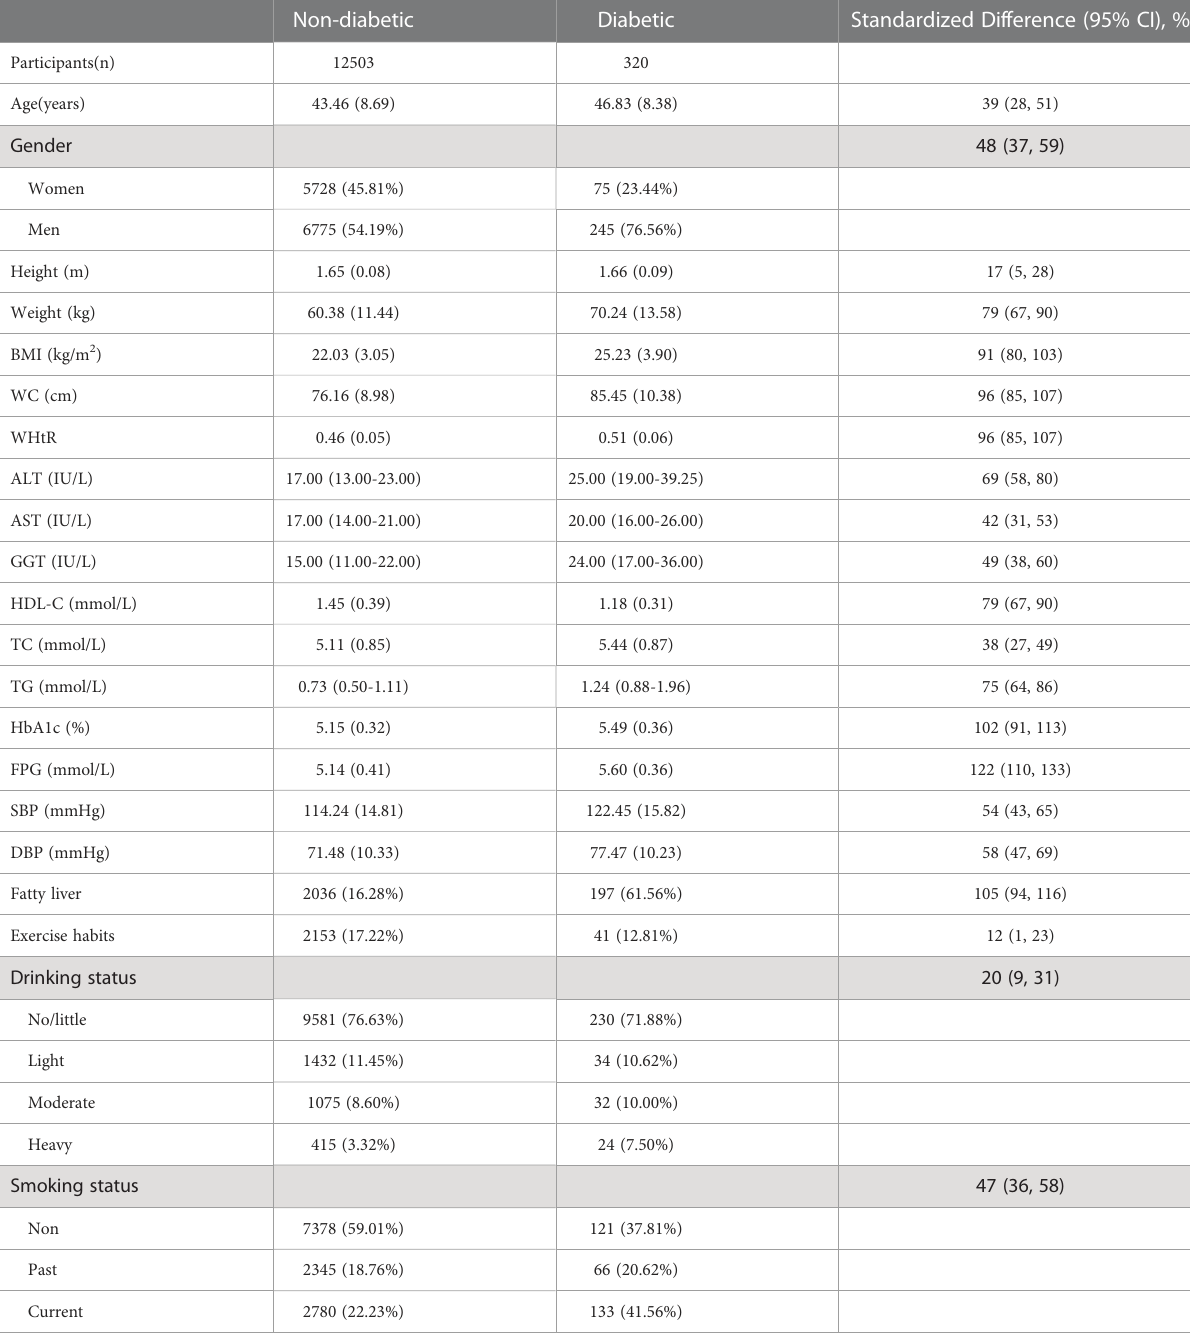
TABLE 1 Baseline demographic, lifestyle, and laboratory characteristics in subjects with and without diabetes.